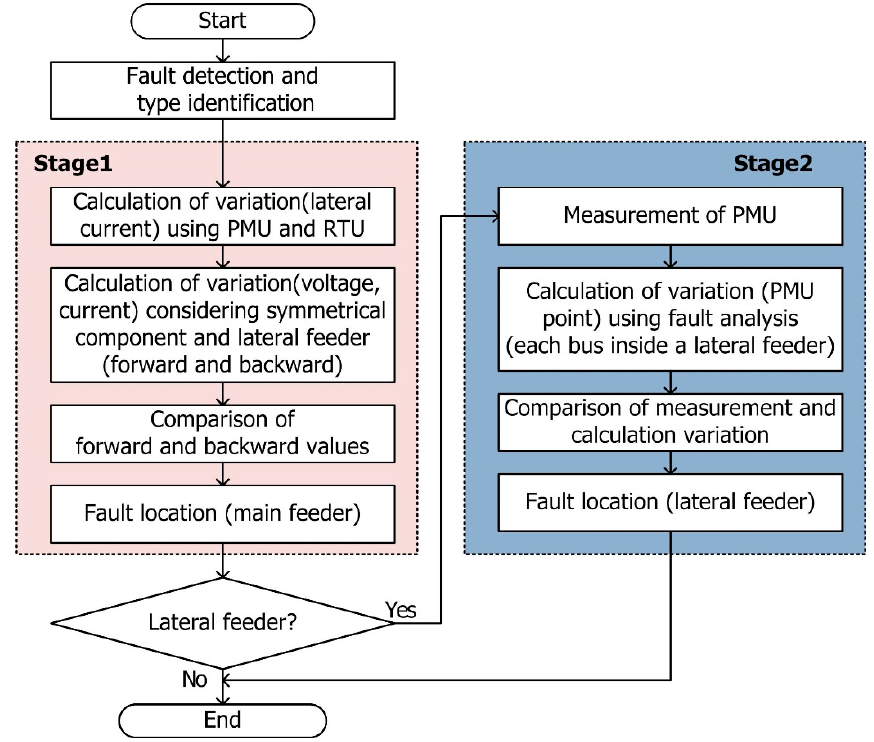
Figure 3. Overall flow chart of the proposed fault location method.